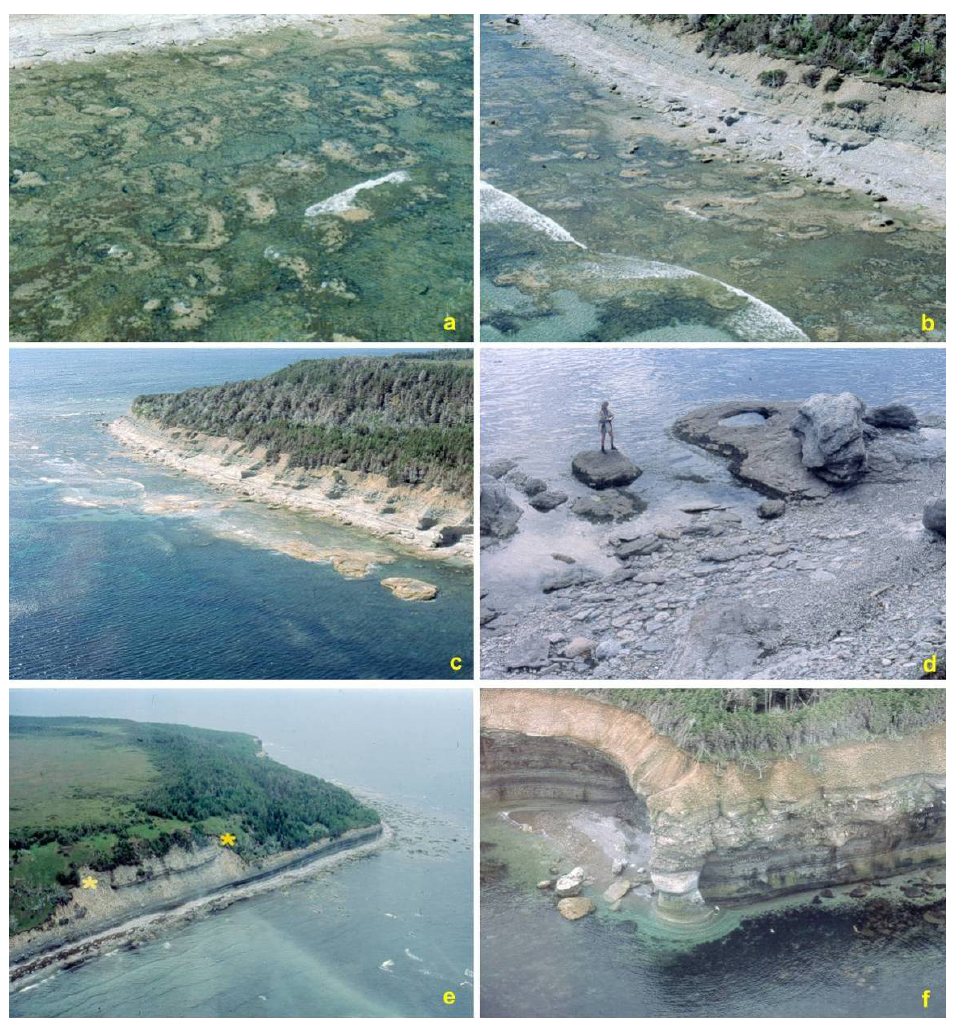
Figure 3. Helicopter views at East Point. ( a ) tidal flat and bluffs some 500 m NW of East Point, displaying ca. 15 reefs on the tidal flats; ( b ) view of about ten reefs in the bluffs and on the tidal flats, and exposing most of the member; ( c ) western tidal flat outcrops of the reefs, close to where the base of the member occurs: an isolated large reef at the right side is 50–60 m across; ( d ) tidal flat outcrop at East Point, marked by several large, partially wave-eroded reef cores and flanks (Darrel Long for scale, facing a reef core to the right); ( e ) East Point itself (bluff jutting out to the right), with last of the easterly reef outcrops, and the overlying recessive shaly Richardson Member of the bluffs, in turn covered by the resistant weathering Cybèle Member of the Jupiter Formation; ( f ) most westerly accessible reef outcrop, showing almost the full thickness of the East Point Member (top of cliff with about 3 m thick glacial deposits) and 4–7 m of the underlying Goéland Member of the Menier Formation (A241, location of